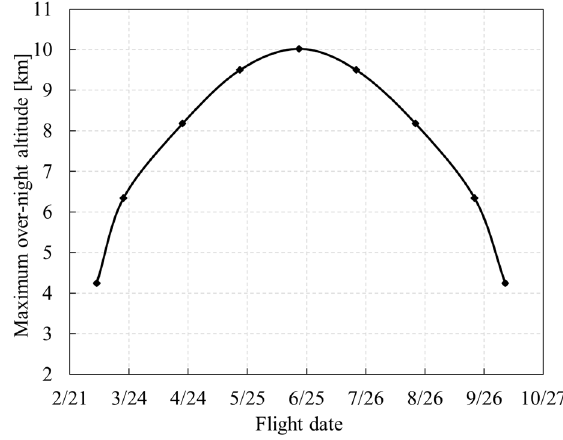
Figure 25. Influence of flight date on maximum overnight altitude.